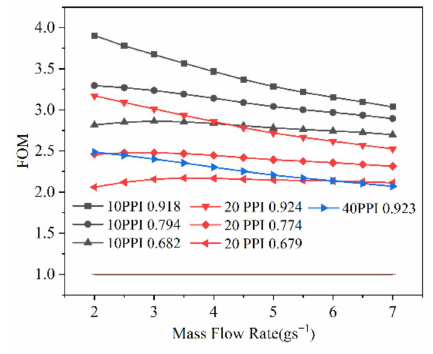
Figure 9. FOM versus mass flow